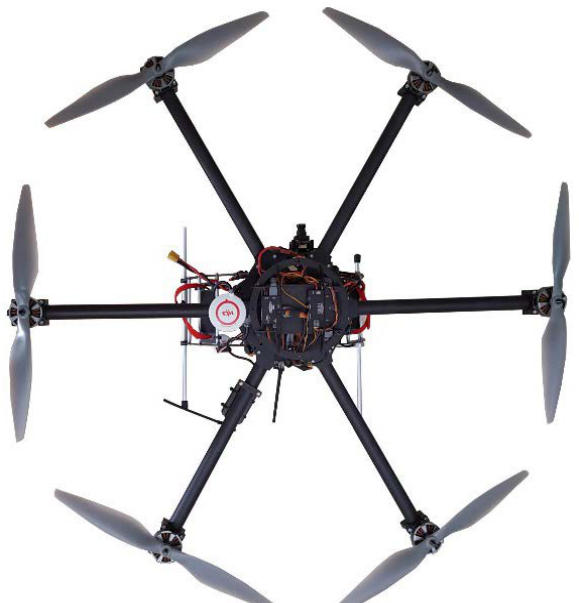
Figure 2: The employed UAV for the photogrammetric aerial